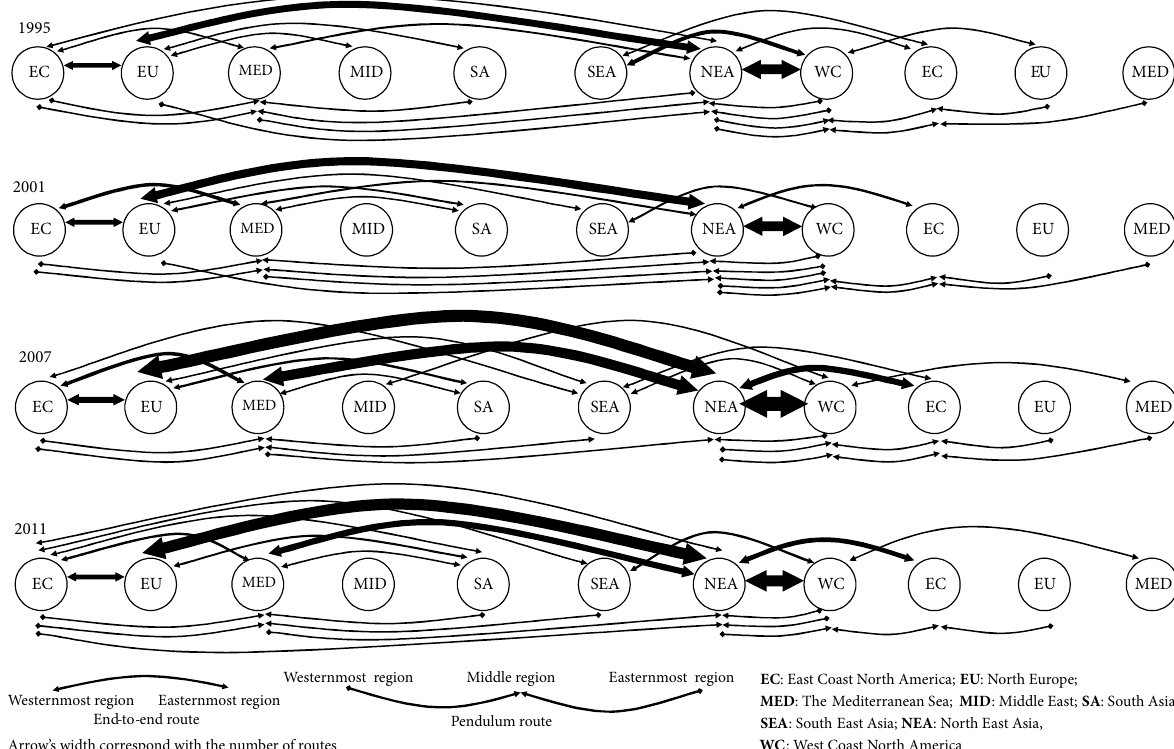
EC : East Coast North America; EU : North Europe; MED : The Mediterranean Sea; MID : Middle East; SA : South Asia; Pendulum route SEA : South East Asia; NEA : North East Asia, WC : West Coast North Arrow’s width correspond with the number of routes Figure 10. ETE and pendulum routes on the shipping network (EC – East Coast North America; EU – North Europe; MED – Mediterranean Sea; MID – Middle East; AS – South Asia; SEA – South East Asia; NEA – North East Asia;